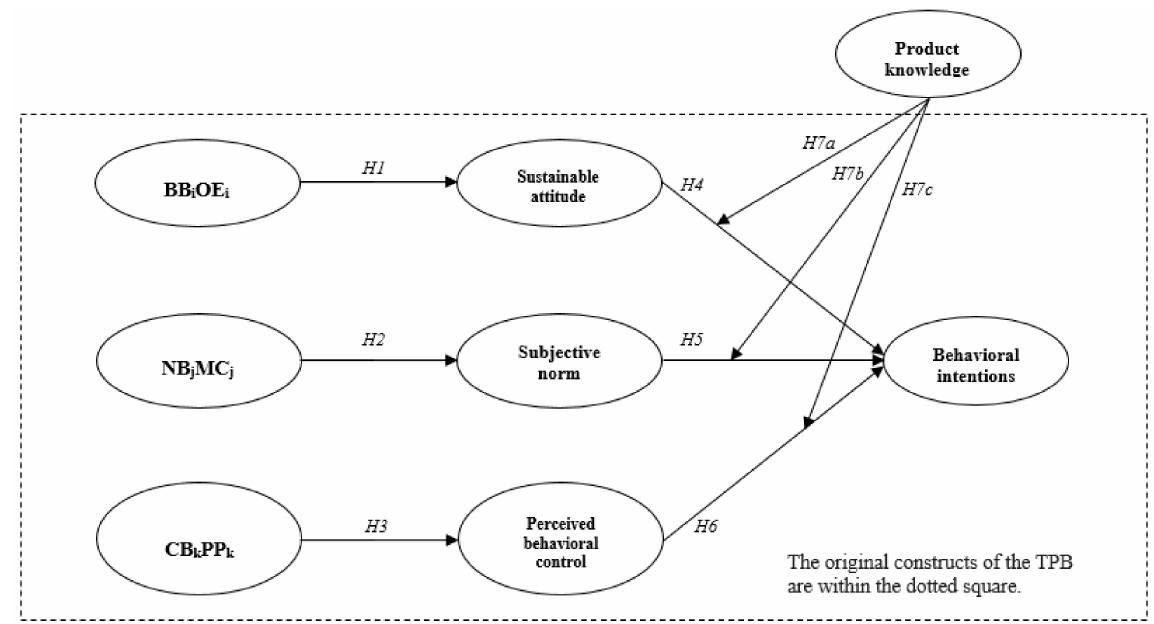
Figure 1. Proposed conceptual model. Note: BB = behavioral beliefs, OE = outcome evaluation, NB = normative beliefs, MC = motivation to comply, CB = control beliefs, and PP = perceived